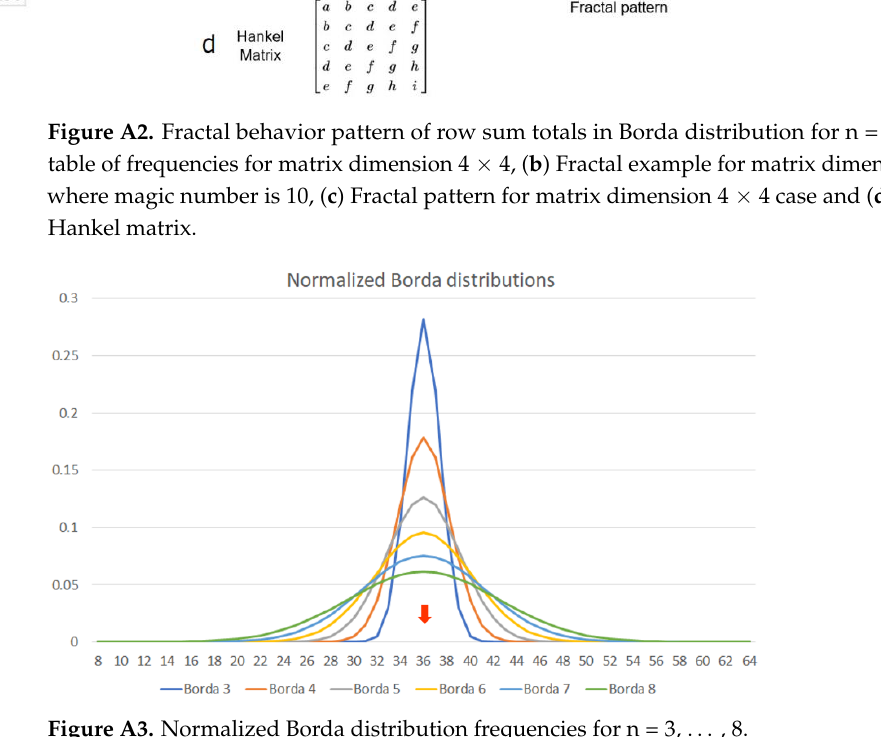
Figure A3. Normalized Borda distribution frequencies for n = 3, …, 8 .